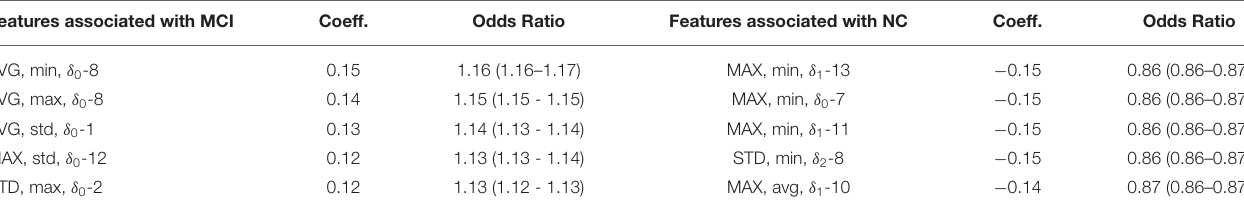
TABLE 4 | Top five MFCC feature coefficients associated with MCI compared to the top five feature coefficients associated with NC. Features associated with MCI Coeff. Odds Ratio Features associated with NC Coeff. Odds